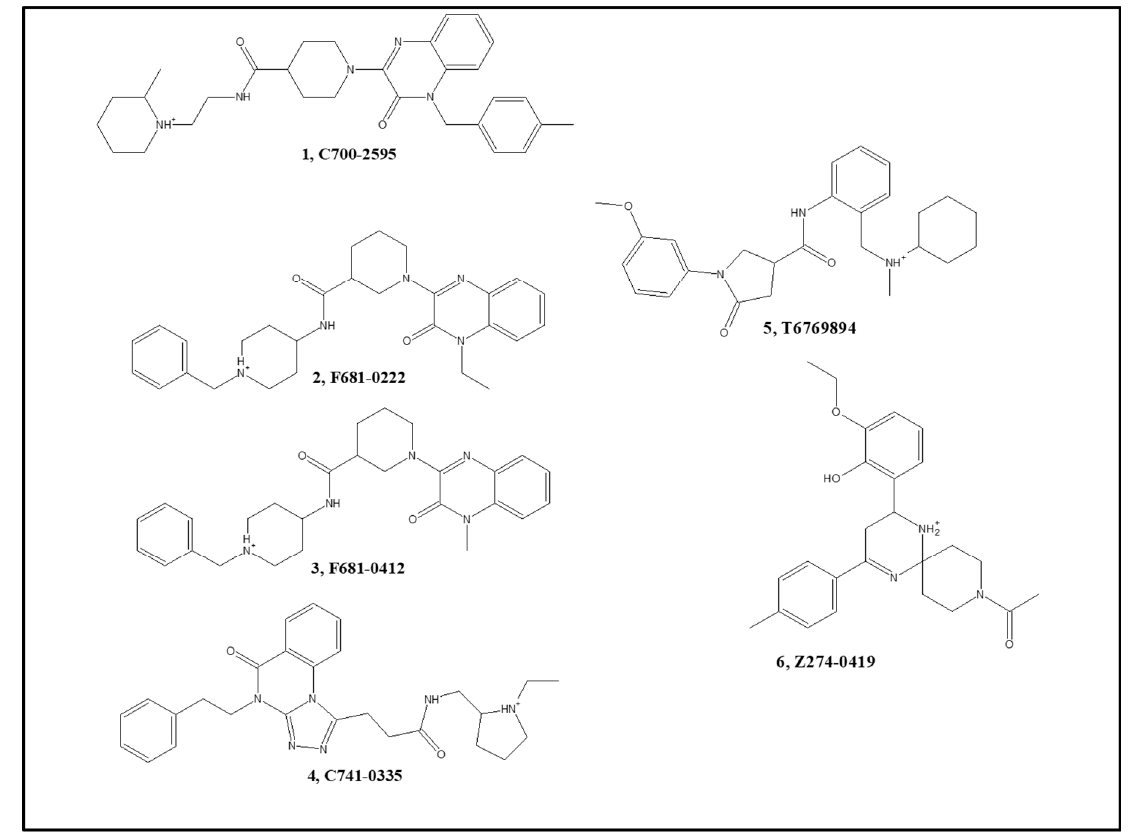
Figure 4. The six hit compounds. A β 42 protein in the brain homogenates was detected by ELISA method. Treatment of animals with compound 2, F681-0222, for 14 days at a dose of 25 mg/kg/day de- creased the secretion of A β 42 amyloid precursor in the insoluble fraction and even more in the soluble fraction (Figure 5). While compound 2 showed significant reduction in the soluble A β 42 in brain tissue, it had minimal effect on the A β 40 soluble fraction (see Supplementary Excel File, Table S19E).